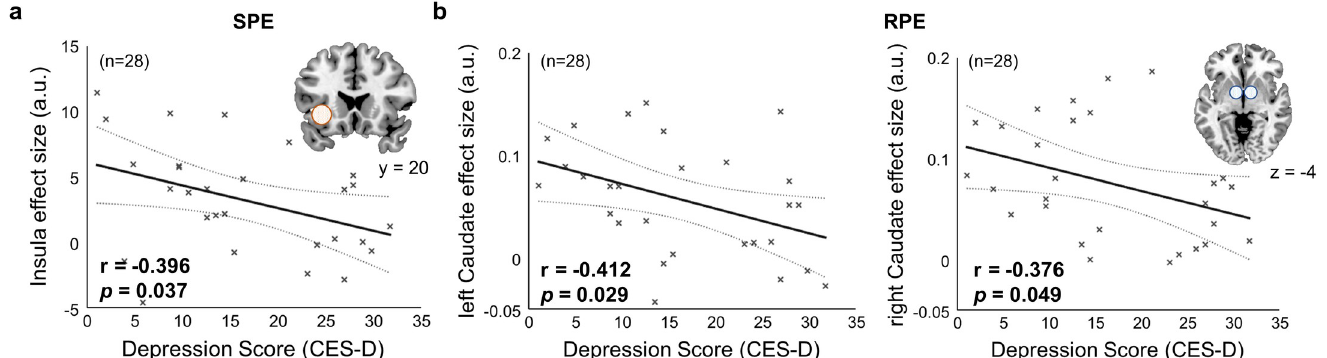
Fig 6. Parametric effect of subclinical depression on model-based and model-free learning. (a) Effects of subclinical depression on neural encoding of state prediction error (SPE) information (n = 28). The shaded circles represent seed regions for which parameter estimates of the GLM analysis were extracted. The seed region is the left insula, and the parameter estimates were extracted from our GLM analysis which regressed the SPE signal against the BOLD response ([–36,20,–4], z-score = 4.49; Fig 5). The estimated effect size for the left insula is negatively correlated with the depression score. (b) Effects of subclinical depression on reward prediction error (RPE) response (n = 28). The estimated effect size of RPE for bilateral caudate (left: [–4,6,–4], z-score = 4.50, right: [4,8,–4], z-score = 5.30) is negatively correlated with the depression score. a.u. stands for arbitrary units.